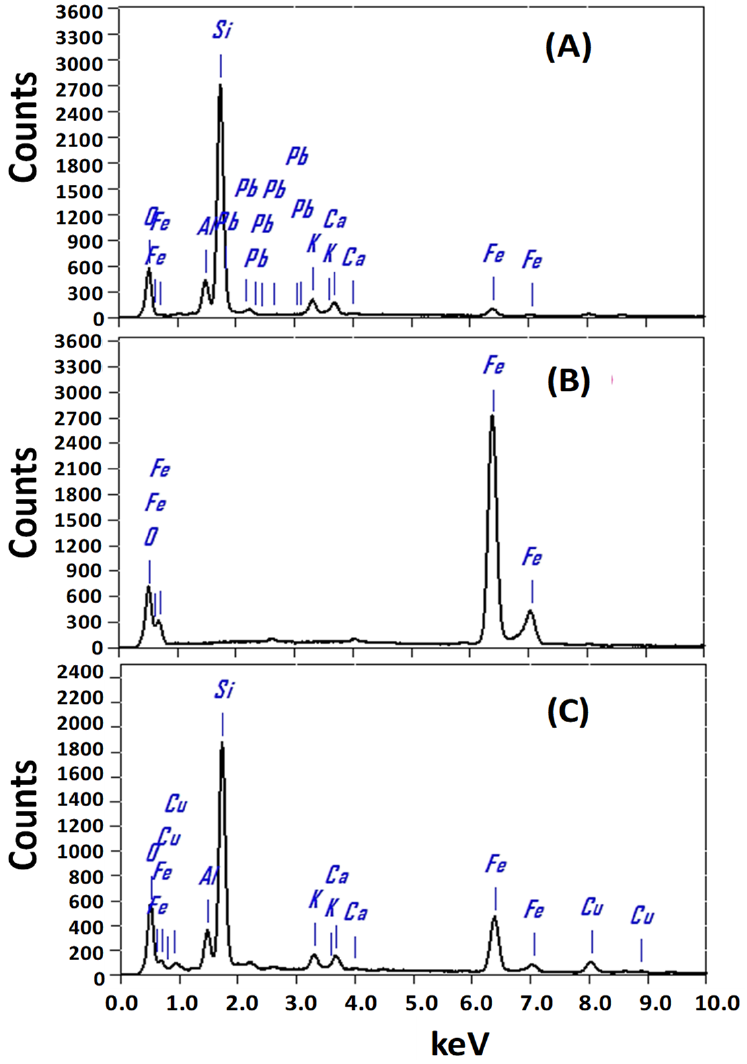
Figure 4. EDX spectrum of ( A ) zeolite, ( B ) Fe 2 O 3 , and ( C ) Fe 2 O 3 /zeolite